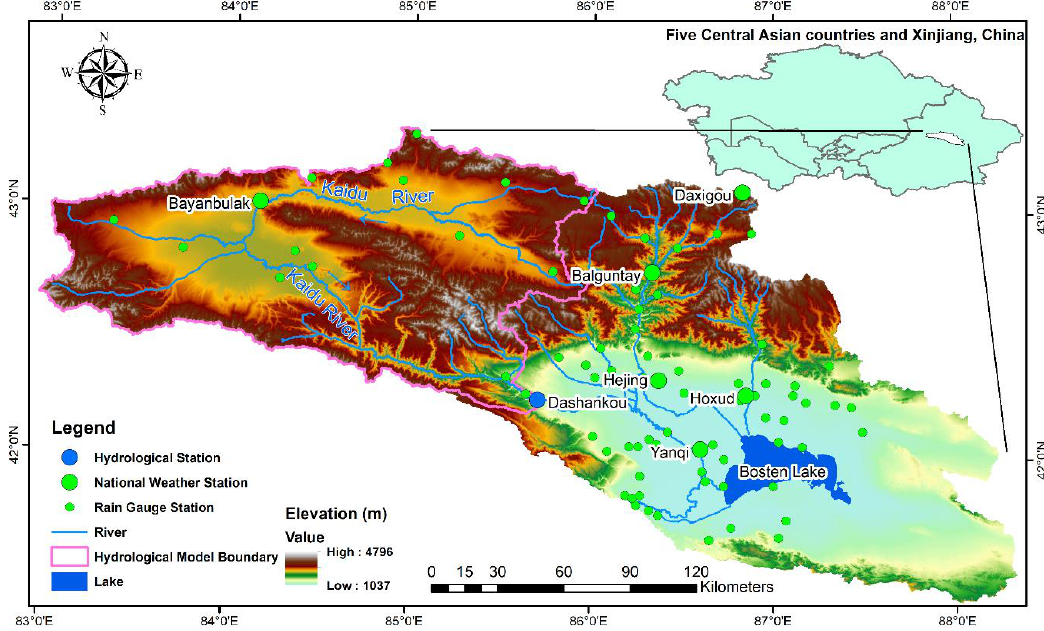
Figure 1. Study area (based on map sources: Department of Natural Resources of Xinjiang Uygur Autonomous Regions Xin S (2019) No.044).